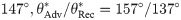
(a) Images showing the seasonal changes of a Katsura tree from spring to fall. The leaf color changes to reddish green—green—yellow—yellowish brown—brown. (b) Images of a sliding droplet on green and brown leaves to show the contact angles. The green leaf exhibits a superhydrophobic surface (147°,θAdv*/θRec*=157°/137°) whereas the brown leaf becomes less hydrophobic (123°,θAdv*/θRec*=151°/96°).